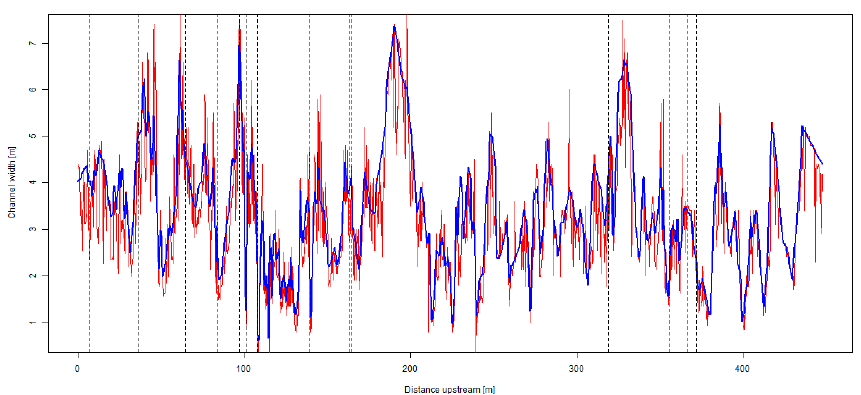
Figure 9. Channel width as derived by cmgo (blue line) and RivMAP (red line) for 1506 locations along a 449m reach of a natural channel (Fig. 10) in the upstream direction. The vertical dashed lines mark our points at which we investigated the width manually in a GIS.